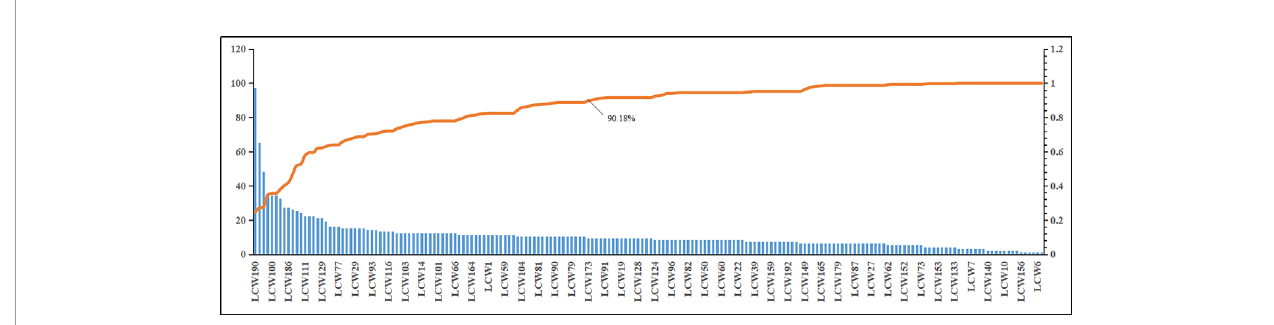
FIGURE 7 | The CI and CI accumulation for KGEC selection in LCW. The bar diagram and trend line diagram are used to visualize the targets coverage of effective proteins of the LCW components and the contribution accumulation results, respectively.